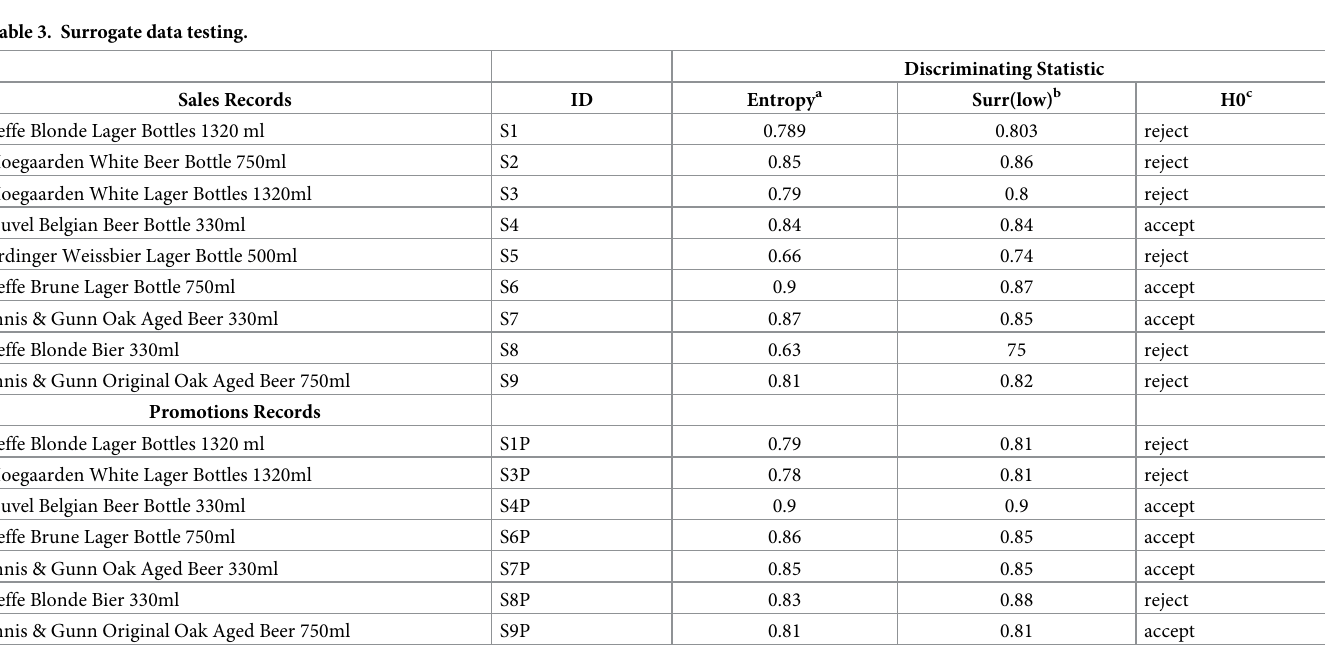
Table 3. Surrogate data